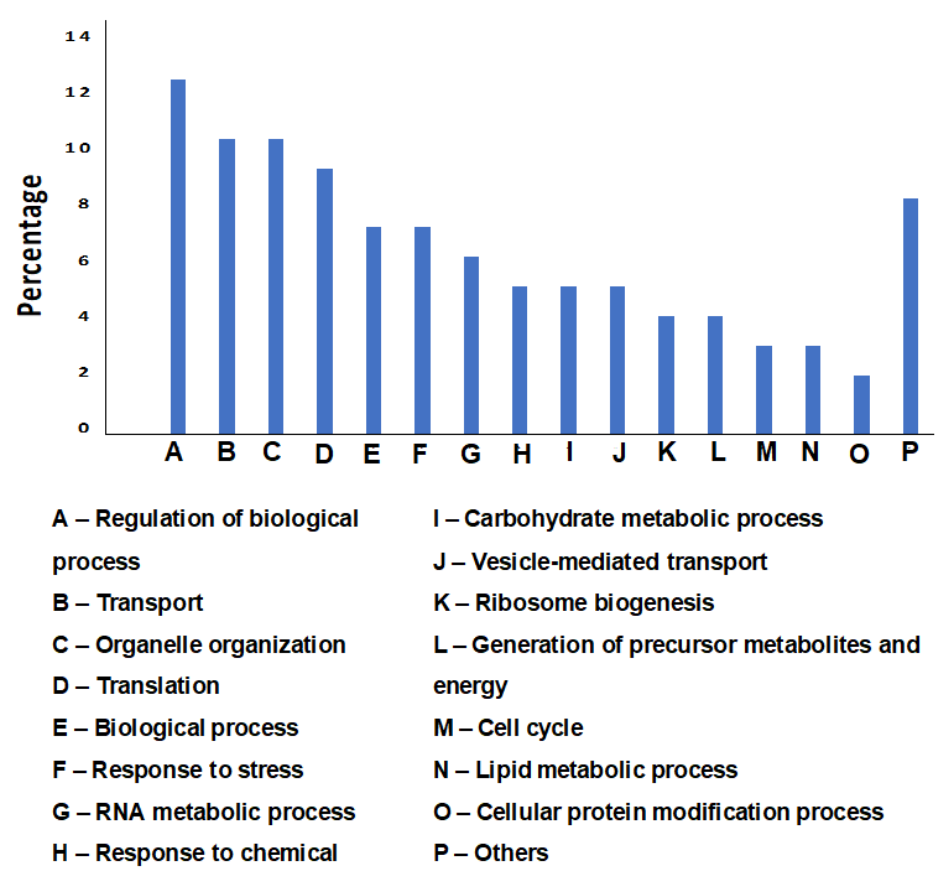
Figure 1. Bar graph showing gene ontology enrichment analysis of biological processes for the proteins identified in the cell wall extract. Biological processes that were common to <5% of the proteins were excluded from the chart.